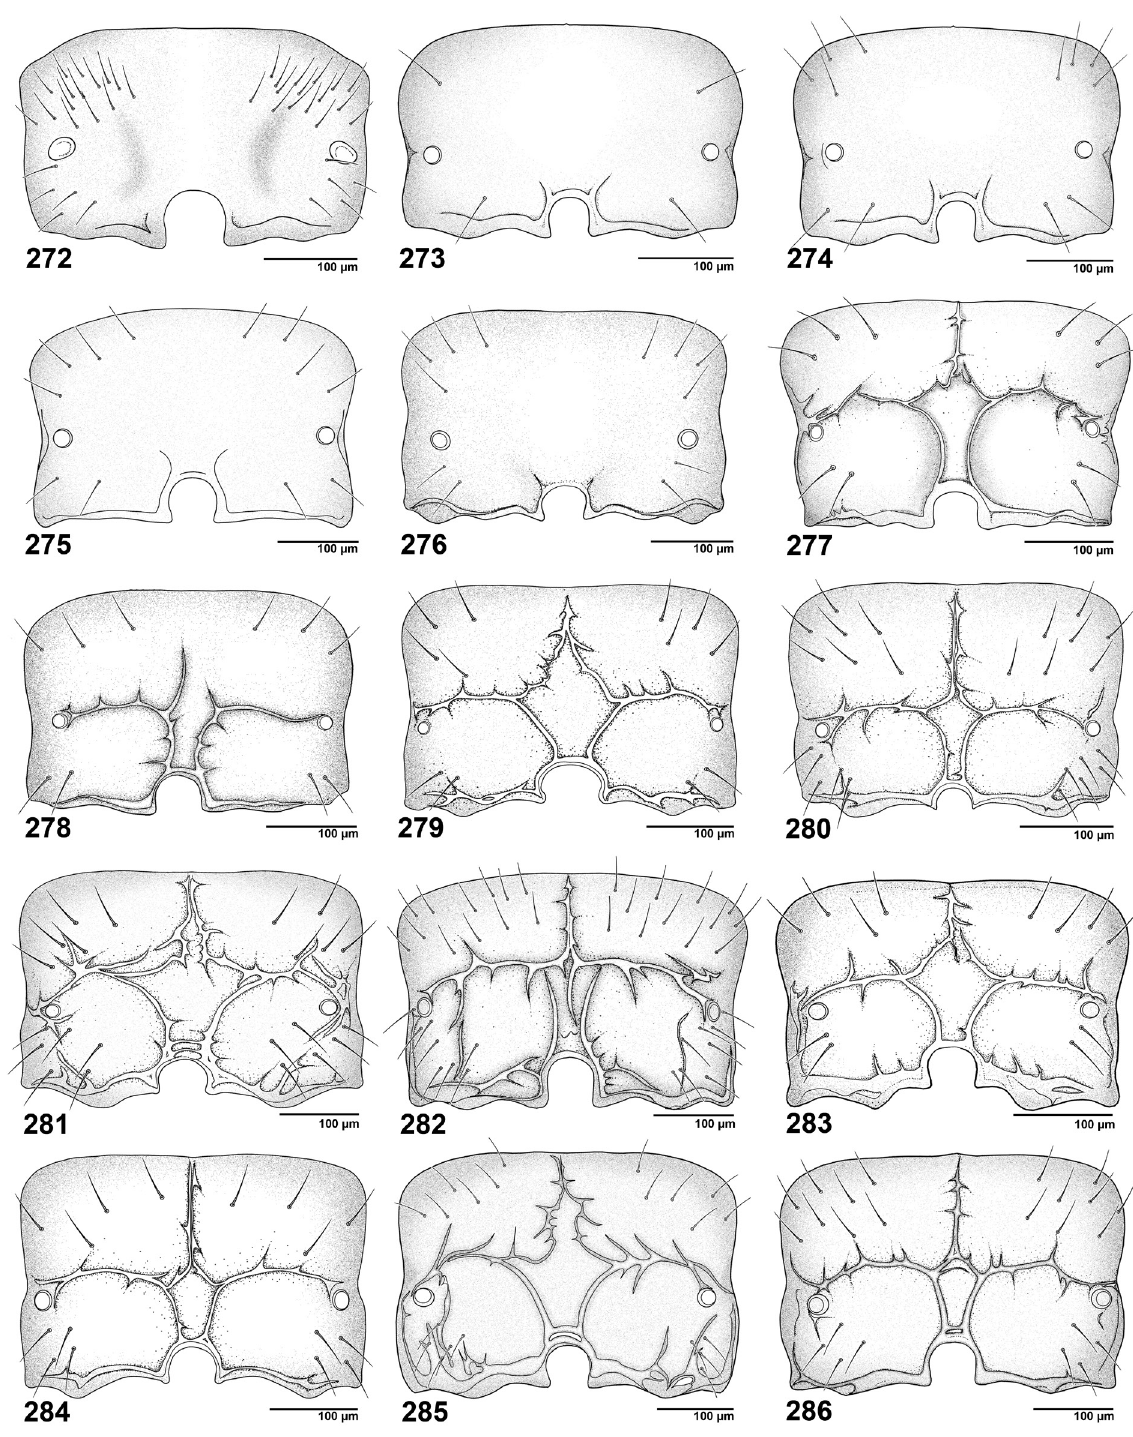
Figs 272–286. Dorsal aspect of propodeum (♀): 272 . Aclitus obscuripennis . 273 . Adialytus ambiguus . 274 . Adialytus salicaphis . 275 . Adialytus thelaxis . 276 . Adialytus veronicaecola . 277 . Aphidius absinthii . 278 . Aphidius arvensis . 279 . Aphidius asteris . 280 . Aphidius avenae . 281 . Aphidius banksae . 282 . Aphidius cingulatus . 283 . Aphidius colemani . 284 . Aphidius eglanteriae . 285 . Aphidius eadyi . 286 . Aphidius ervi